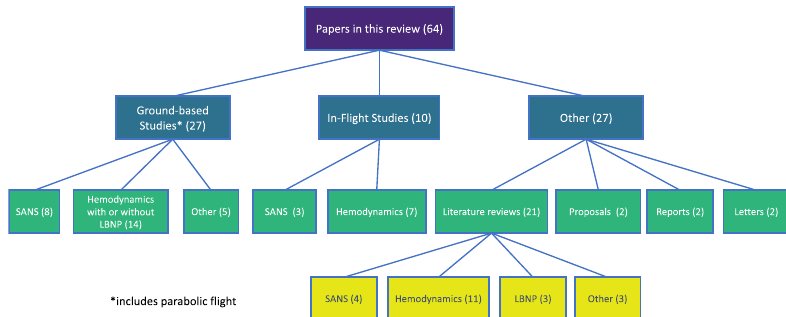
Fig. 2 Types of sources included in this review. Distribution of included papers by type of study, type of article, and